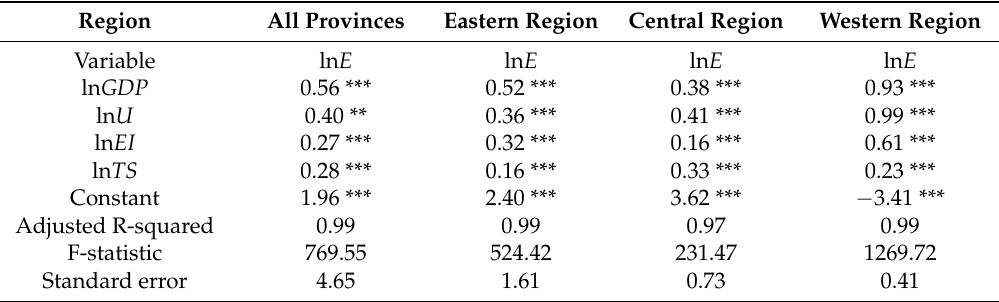
Table 5. Panel estimation results